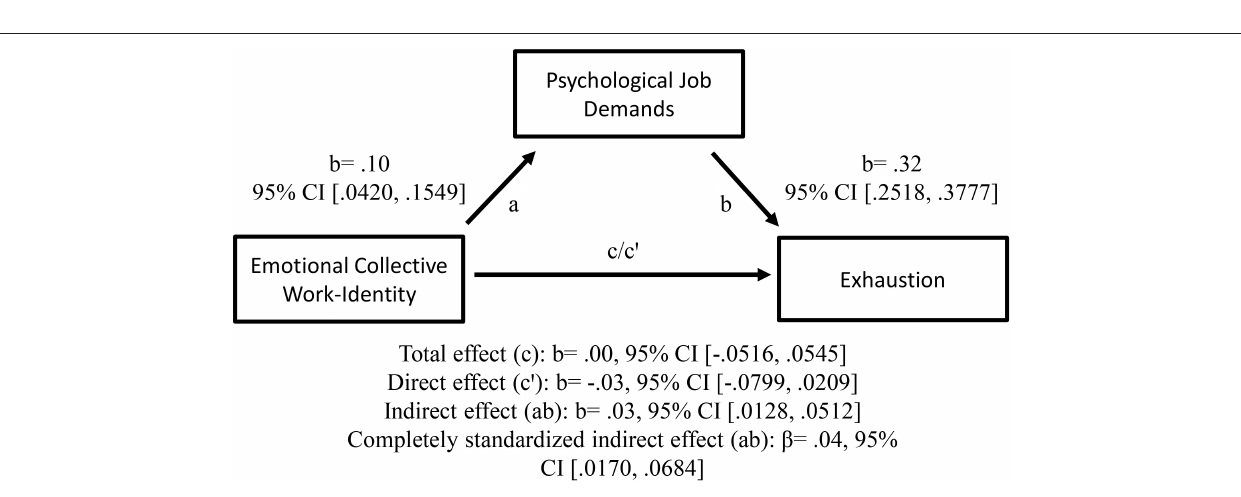
FIGURE 4 | Emotional collective work-identity as a predictor of exhaustion, mediated by psychological job demands. The confidence interval (CI) for the indirect—and completely standardized indirect effect is a BC bootstrapped CI based on 5,000